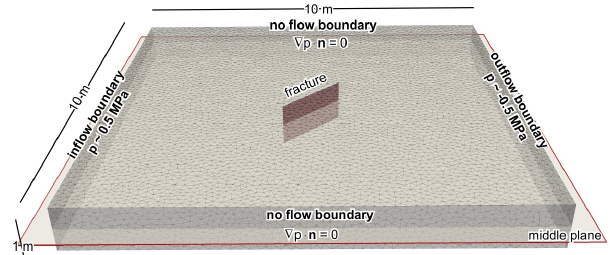
Figure 5. Geometry and boundary conditions for the benchmark case of groundwater flow in a fractured porous medium.